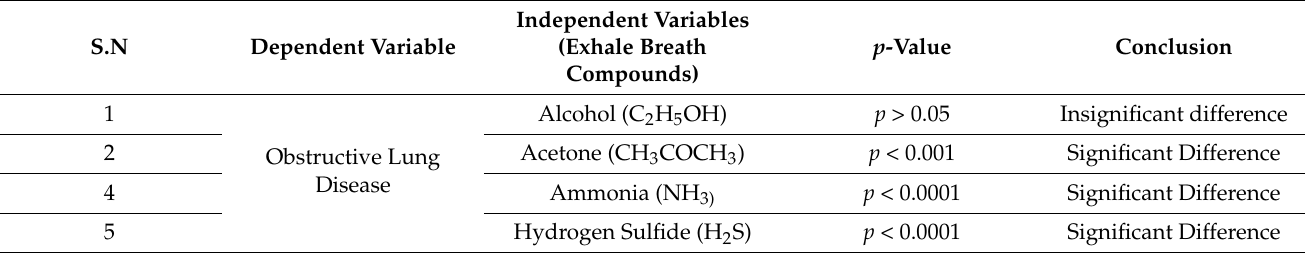
Table 1. Comparison analysis of gases in exhaled breath between obstructive lung disease patients and healthy subjects.